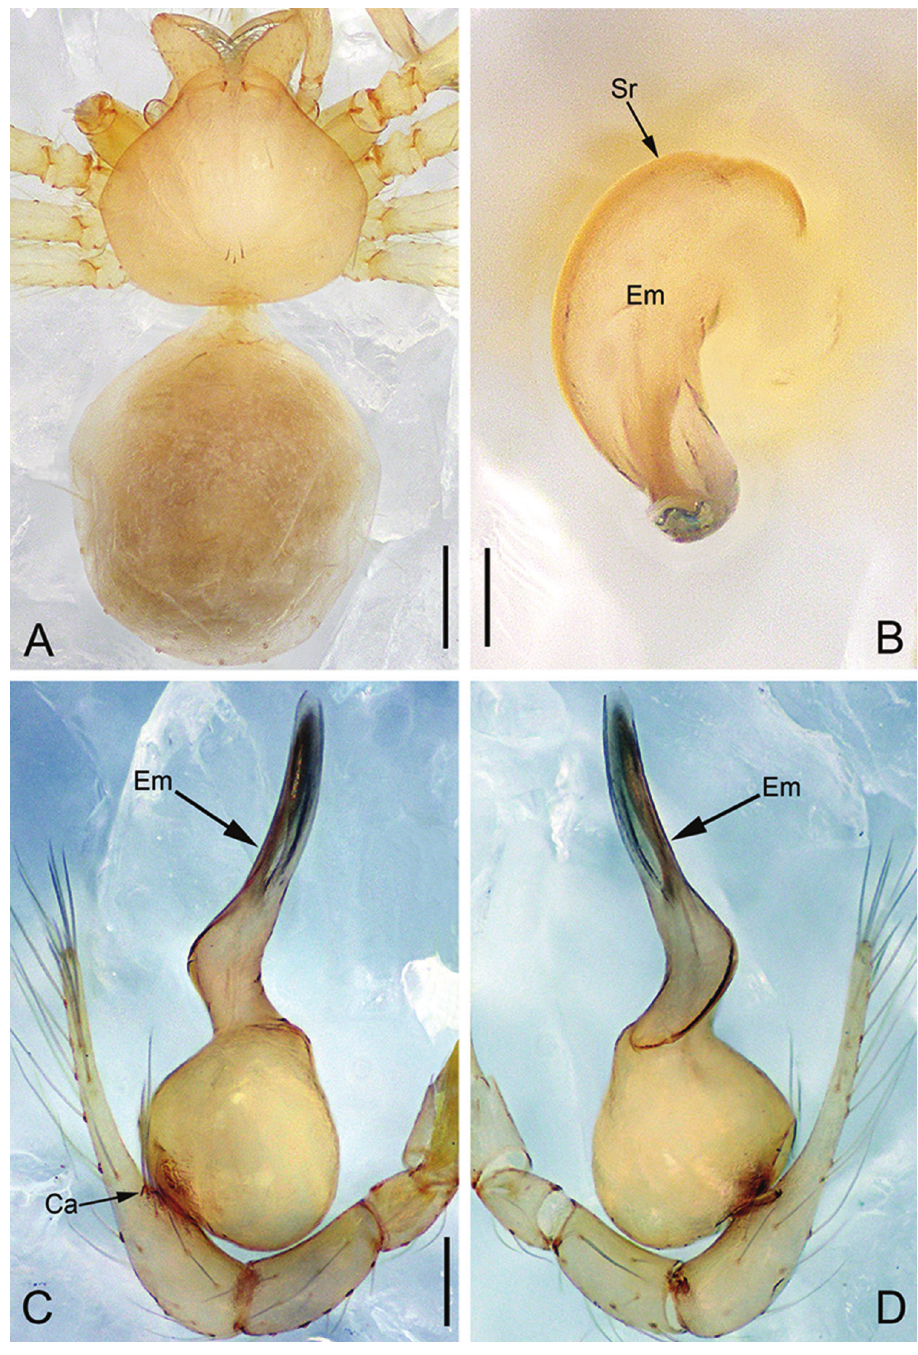
Figure 29. Pinelema zhewang , male. A Habitus, dorsal view B Embolus, apical view C Palp, prolateral view D Palp, retrolateral view. Scale bars: 0.2 mm ( A ), 0.05 mm ( B ), 0.1 mm ( C–D